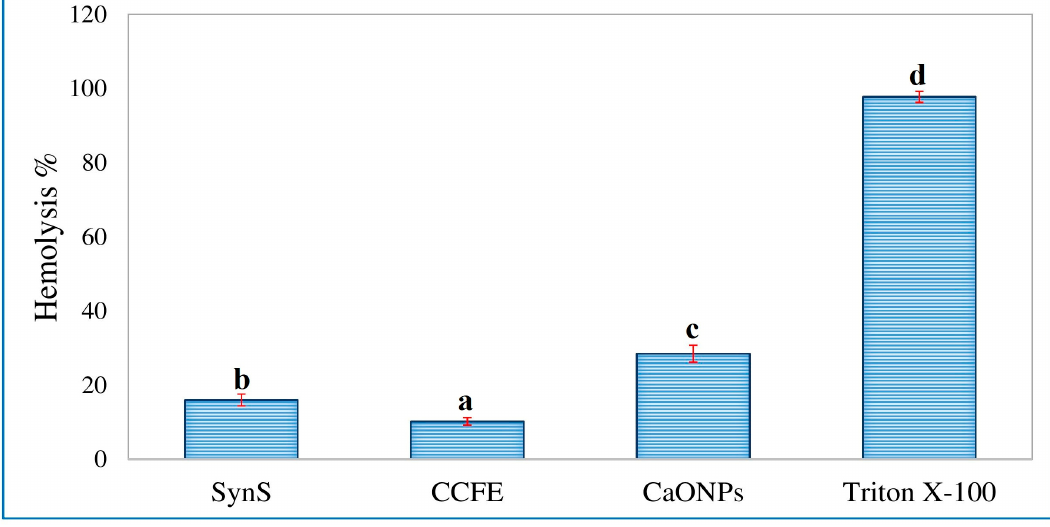
Figure 8. Hemolytic activity of CaONPs, C. colocynthis fruit extracts, and their synergistic solution. SynS—a synergistic solution of calcium oxide nanoparticles and C. colocynthis fruit extracts; CCFE— C. colocynthis fruit extracts; CaONPs—calcium oxide nanoparticles. Data are expressed as mean ± SEM. In one-way ANOVA, the values p < 0.05 were considered significant. The Duncan Multiple Range Test (DMRT) was performed for values that were significantly different. The different alphabets on the bars indicate a significant difference in group means (n = 3). The same alphabets above the bars indicate there was no significant difference among the means of these groups.